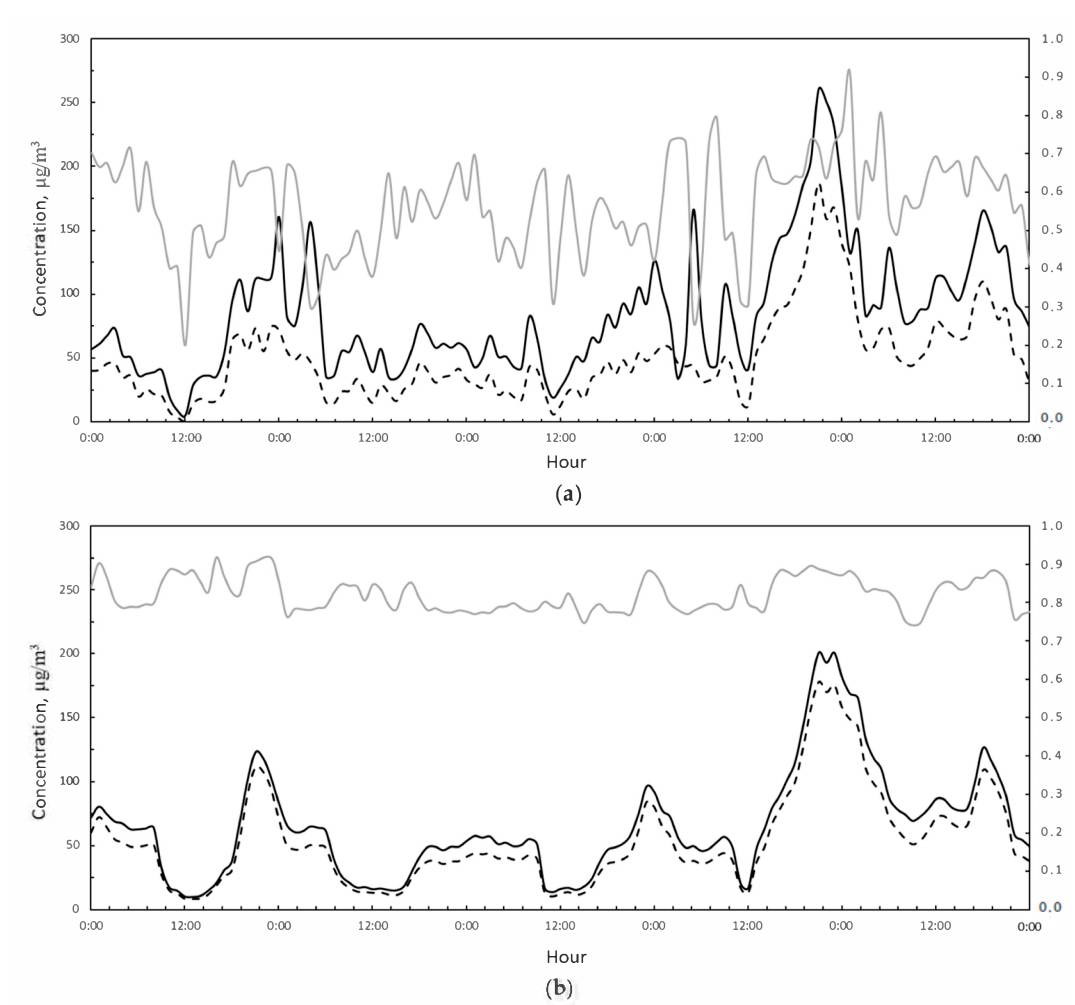
Figure 8. ( a ) PM10 (black solid line), PM2.5 (black dashed line), and PM2.5/PM10 hourly concentrations (grey solid line) measured during the period 23–28 February 2021 at the VC station. ( b ) PM10 (black solid line), PM2.5 (black dashed line), and PM2.5/PM10 hourly concentrations (grey solid line) measured during the period 23–28 February 2021 at the MV